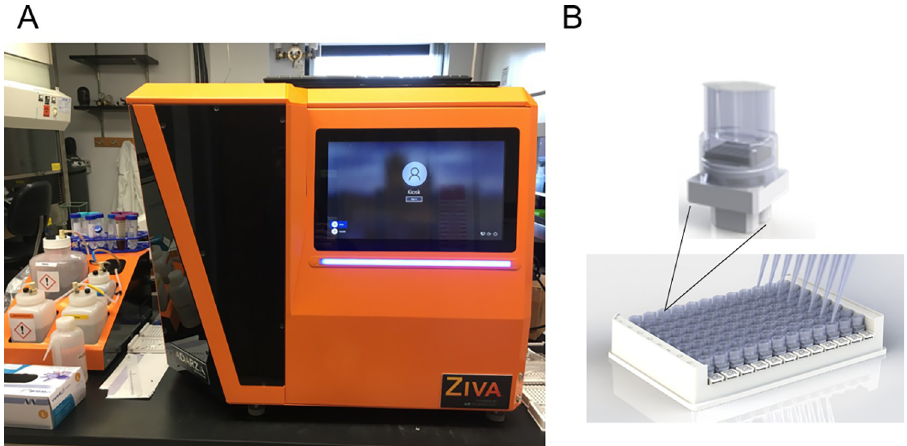
Fig 1. ZIVA system including (A) fully automated instrument and (B) 96-well plate full of AIR chip cartridges and an enlarged single cartridge containing an AIR